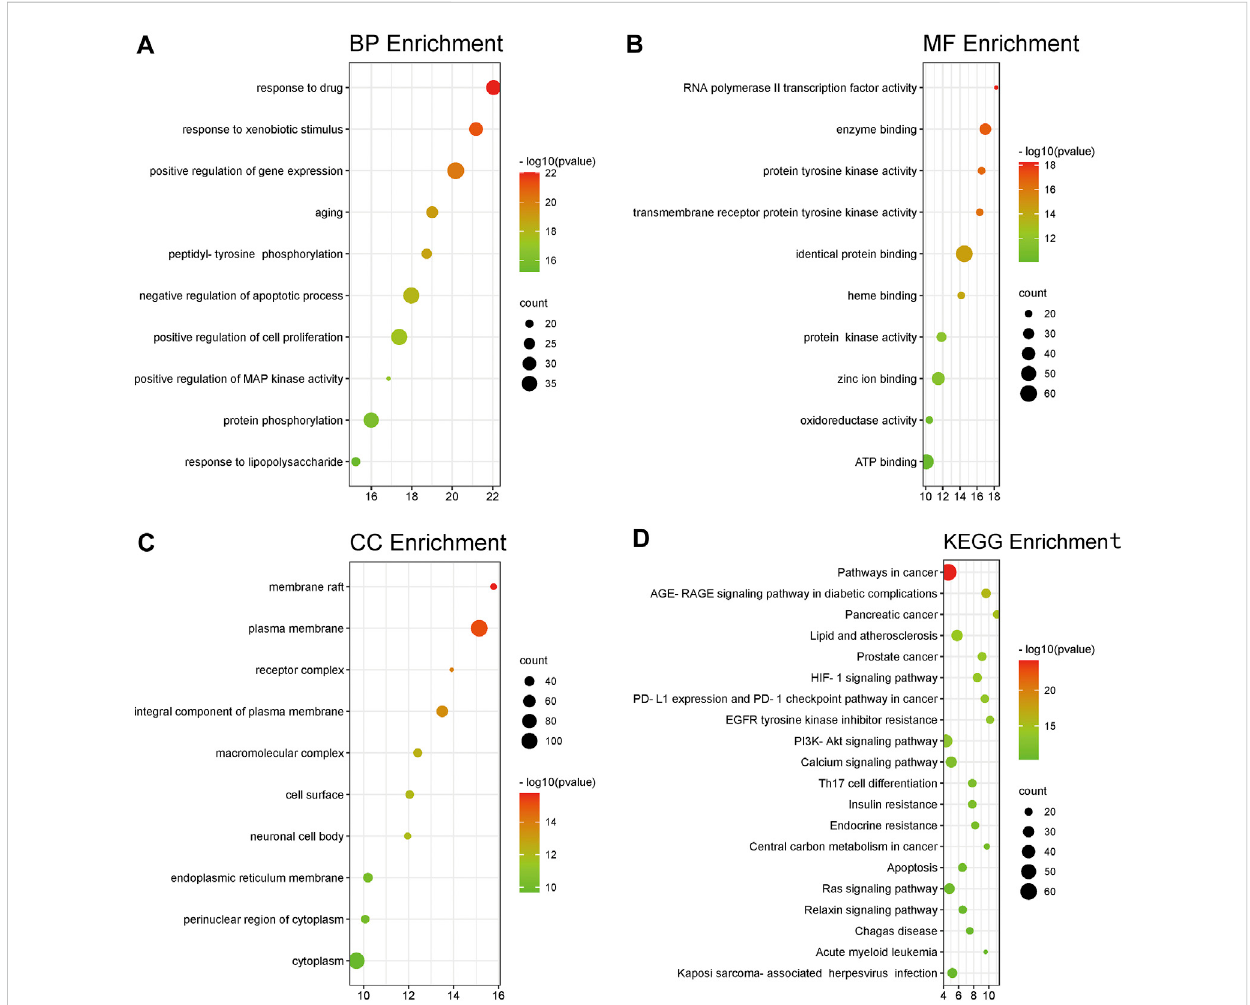
FIGURE 3 (A – C) Analysesof214targetsassociatedwithSjögren ’ ssyndromeusingtheGOdatabase.Thex-axisrepresentssigni fi cantenrichmentoftheseterm counts. The y-axis represents the category of “ biological process ” , “ cellular component ” and “ molecular function ” in the GO of target genes ( p < 0.05, top10). (D) Pathway-enrichment analyses usingtheKEGGdatabase.The x-axis representsthecount oftargets ineachpathway; they-axis representsthe primary pathway ( p < 0.01,